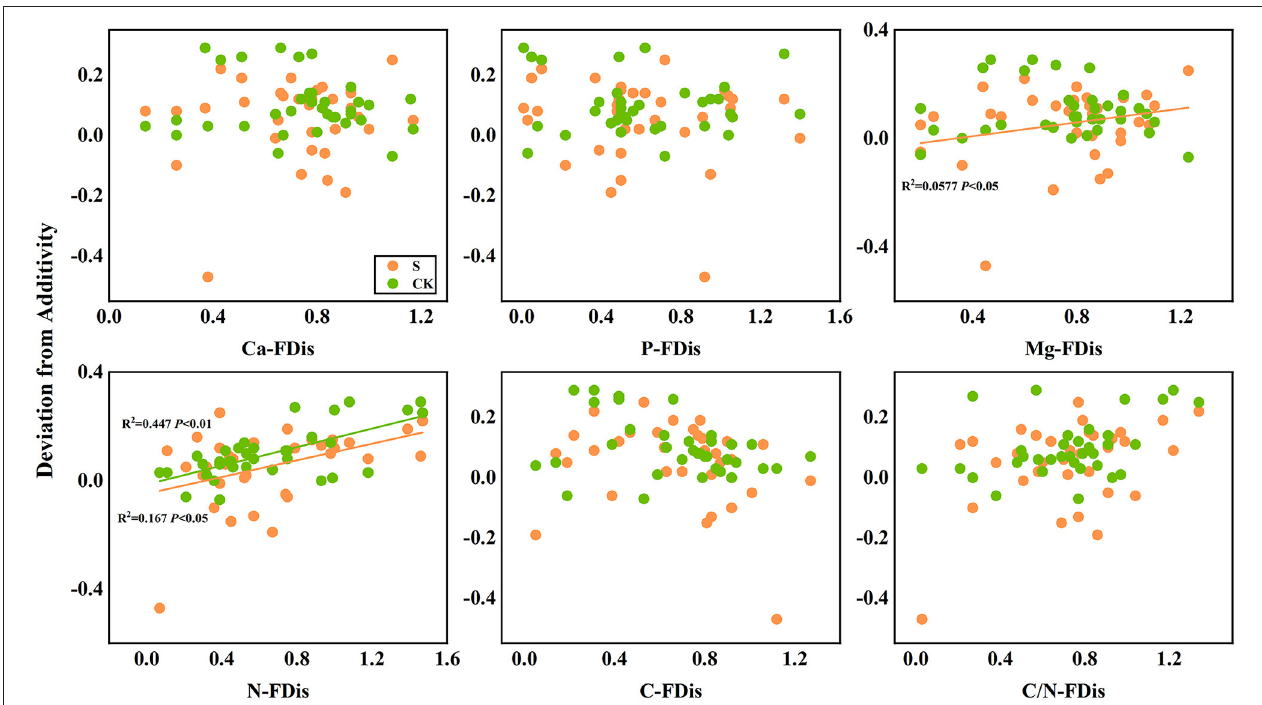
FIGURE 9 | Linear regression relationships between mean mixing effect intensity of litter decomposition andfunctional dispersion (FDis) of litter mixture. S stands for litter that has been decomposed in the submergence environment, and CK stands for litter that has been decomposed in the terrestrial environment.